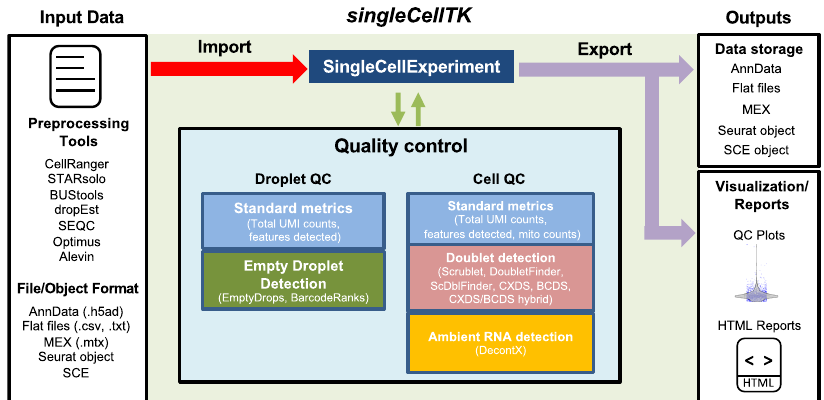
Fig. 1 Overview of the SCTK-QC pipeline. The SCTK-QC pipeline is developed in R and can import datasets generated from various preprocessing tools. The pipeline incorporates various software and tools to perform QC for Droplet and/or Cell matrices within each sample. Tools are included for calculation of standard metrics such as the number of Unique Molecular Identi fi er (UMIs) per cell, detection of empty droplets, prediction of doublets, and estimation of contamination from ambient RNA. The pipeline utilizes the SingleCellExperiment (SCE) R object to store assay data and the derived QC metrics. Data visualization and report generation can be subsequently performed on the imported dataset based on user speci fi ed parameters. All data can be exported to Seurat object, a Python AnnData object, or as Market Exchange Format (MEX) and.txt fl at fi les to facilitate analysis in downstream work fl ows. Table 1 Functions available in the singleCellTK package and the SCTK-QC pipeline along with the corresponding wrapper functions.